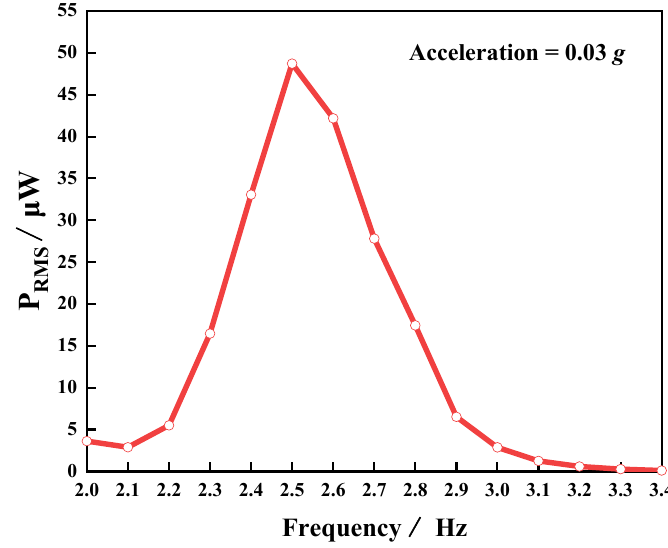
Figure 7. P RMS of PVEH- R as a function of frequency.